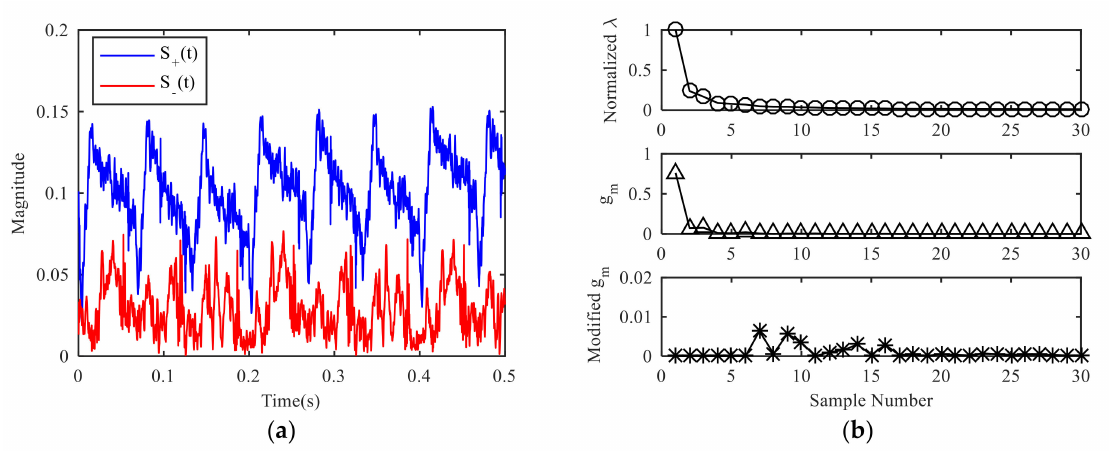
Figure 6. Solution of decomposition layer: ( a ) Newly constructed signal S + ( t ) and S − ( t ) , ( b ) curve of effective singular